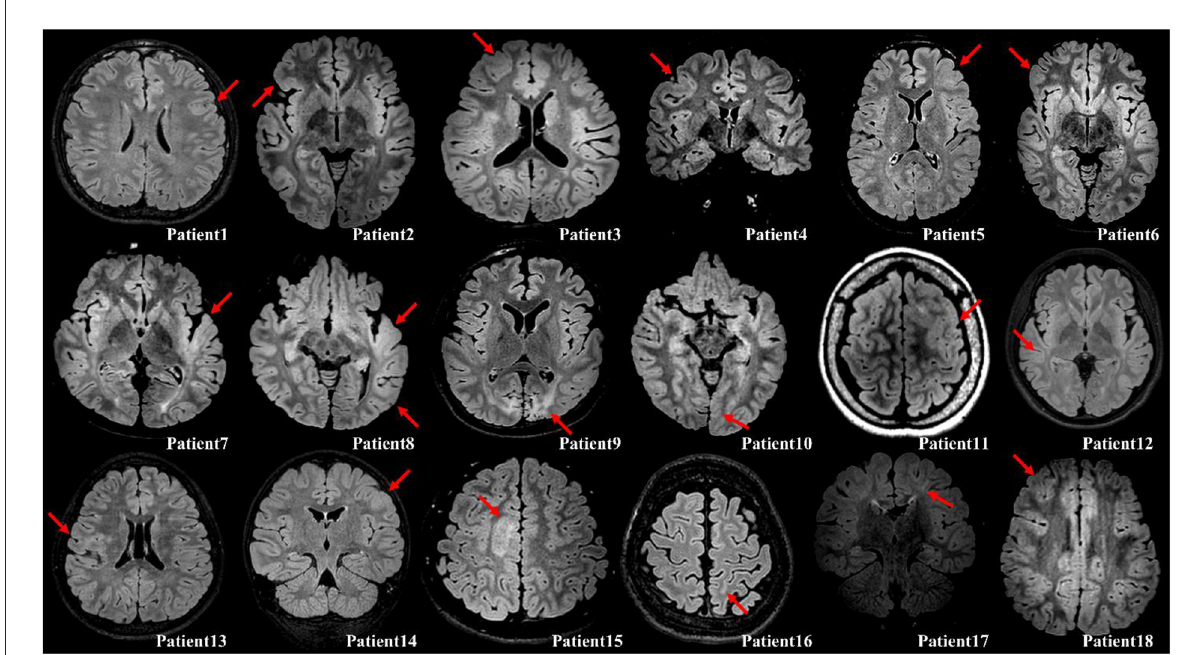
FIGURE1 Illustration of the confirmed FCD on fluid attenuation inversion recovery images with either axial or coronal planes (red arrow). Patient 1, Cortical thickening; Patient 2, Cortical thickening and blurring of gray–white matter junction; Patient 3, Cortical thickening; Patient 4, Cortical thickening; Patient 5, Cortical thickening and blurring of gray–white matter junction; Patient 6, Cortical thickening; Patient 7, Cortical thickening, blurring of gray–white matter junction, and subcortical white matter hyperintensity; Patient 8, Cortical thickening and blurring of gray–white matter junction; Patient 9, Destruction on brain gray–white matter on both occipital (Lt > Rt); Patient 10, Cortical thickening and blurring of gray–white matter junction; Patient 11, Cortical thickening and blurring of gray–white matter junction; Patient 12, Cortical thickening and blurring of gray–white matter junction; Patient 13, Cortical thickening, blurring of gray–white matter junction, and subcortical white matter hyperintensity; Patient 14, Cortical thickening and blurring of gray–white matter junction; Patient 15, Cortical thickening and subcortical white matter hyperintensity; Patient 16, Blurring of gray–white matter junction; Patient 17, Subcortical white matter hyperintensity with transmantle sign; Patient 18, Cortical thickening and blurring of gray–white matter junction.